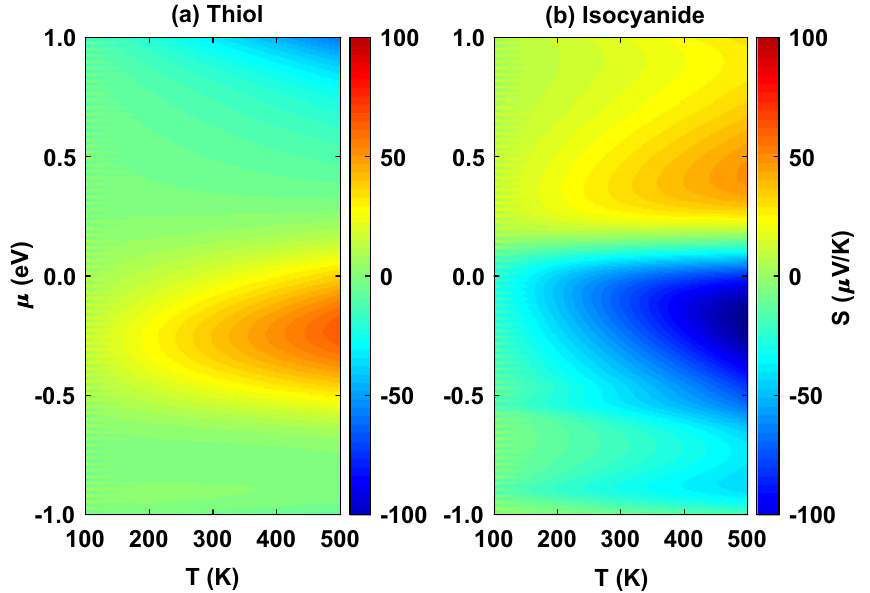
Figure 4. Temperature dependency of the thermopower when the chemical potential of the electrodes is varied systematically for the anthracene molecule coupled to the Au electrodes via ( a ) thiol and ( b ) isocyanide anchoring groups.